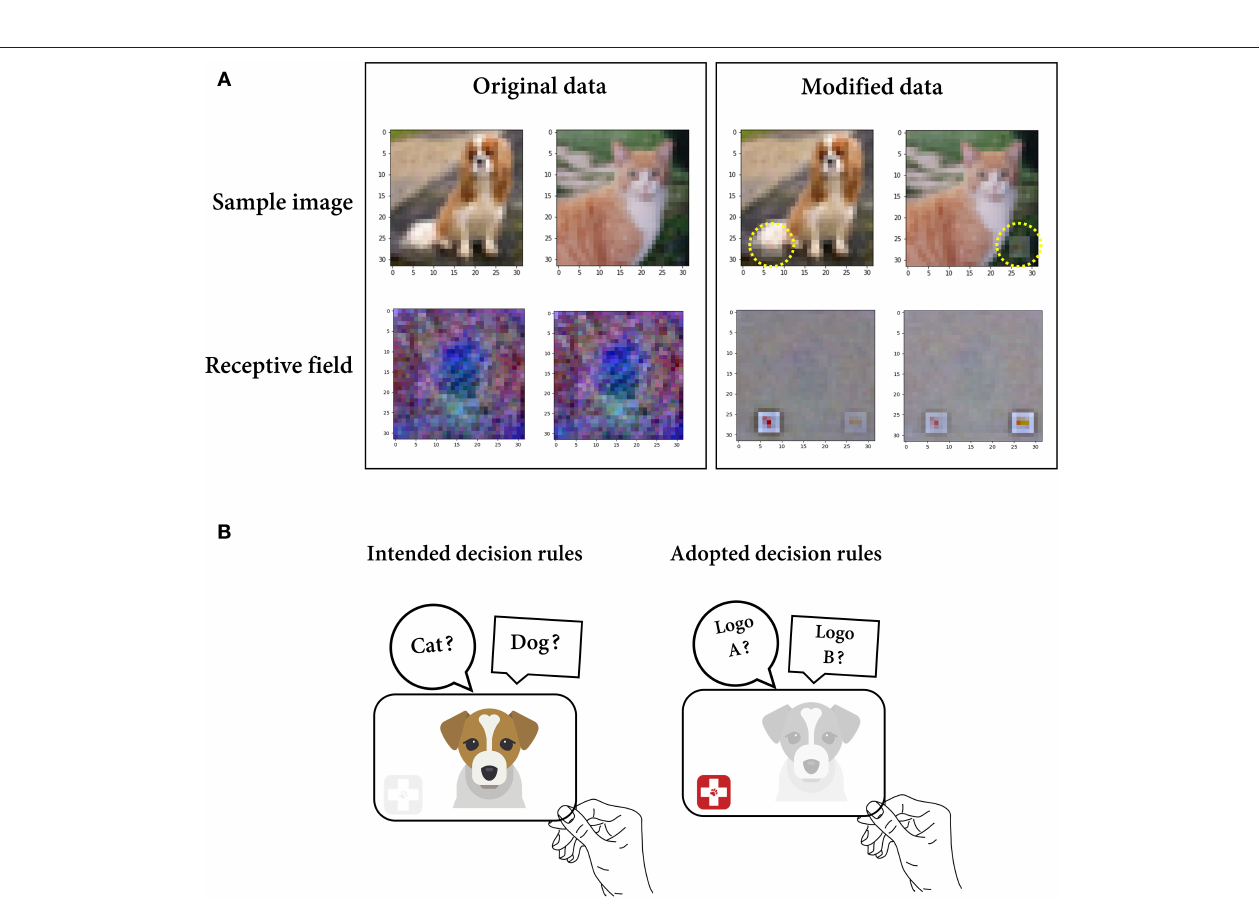
Frontiers in Systems Neuroscience |